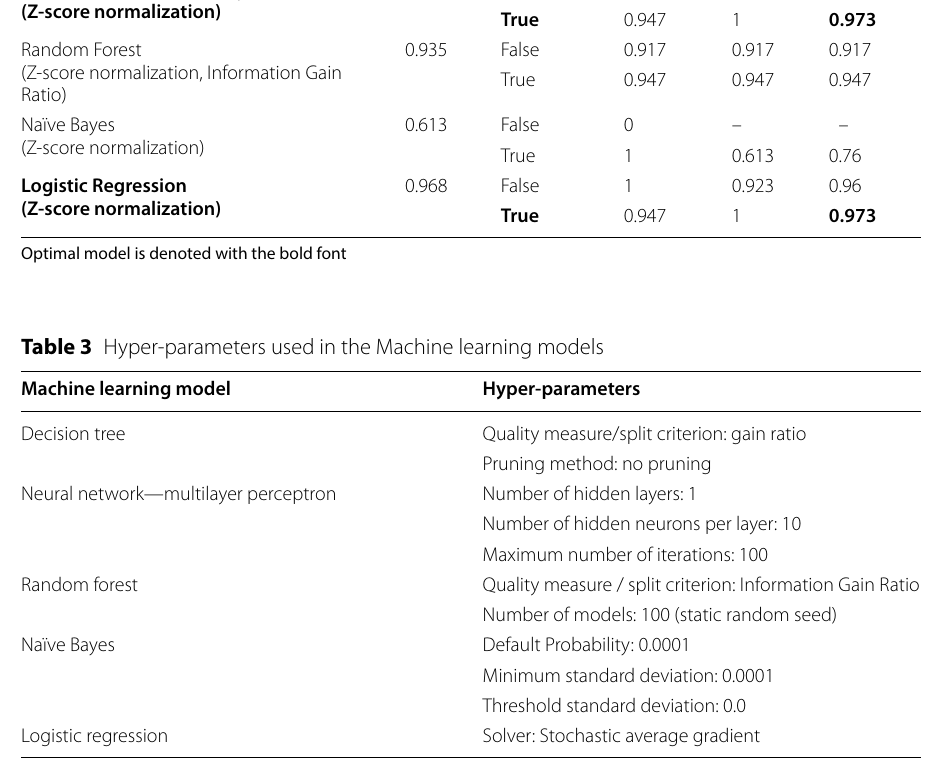
Table 2 Performance evaluation of optimal Machine Learning models